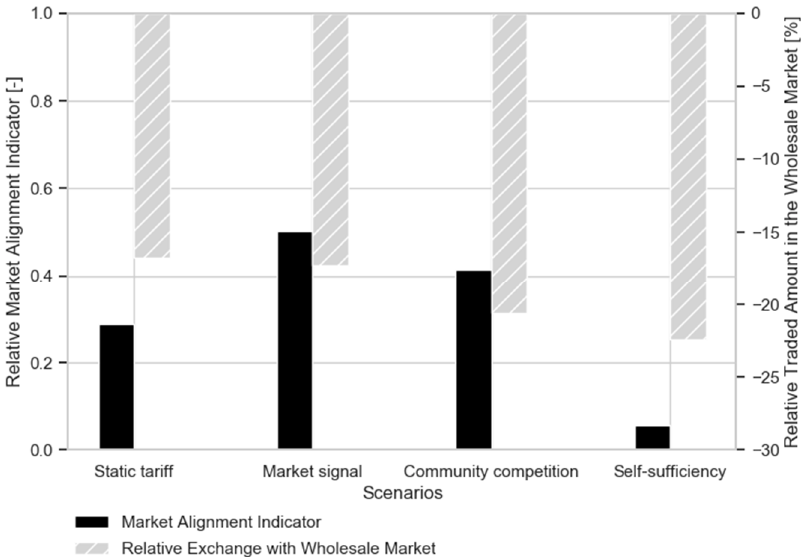
Figure 11. Relative market alignment indicator and reduced exchange with market compared to the BAU scenario.